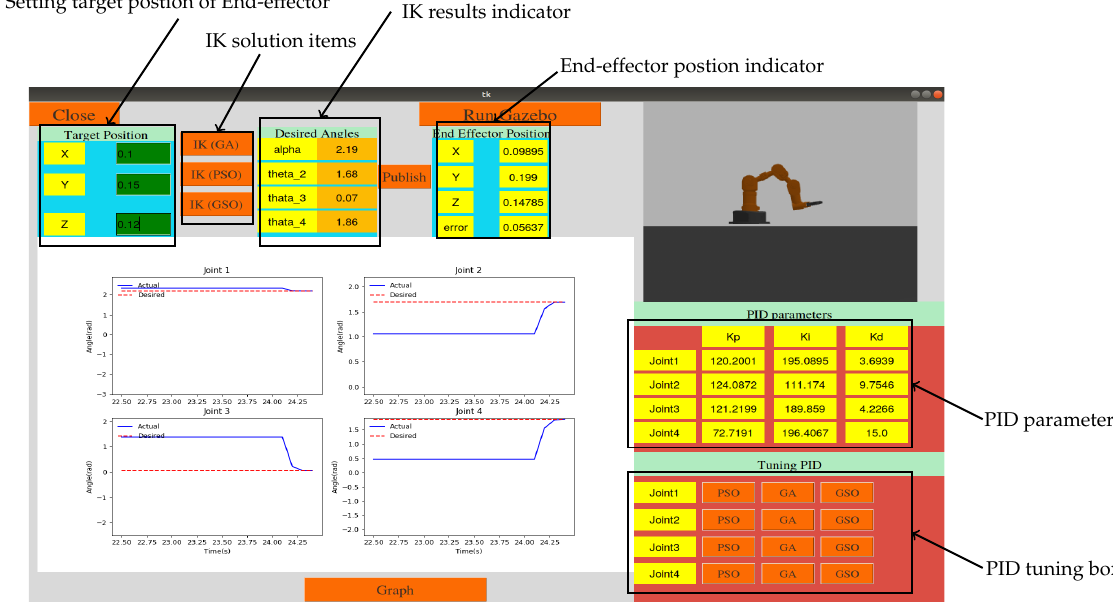
Figure 6. GUI for simulation